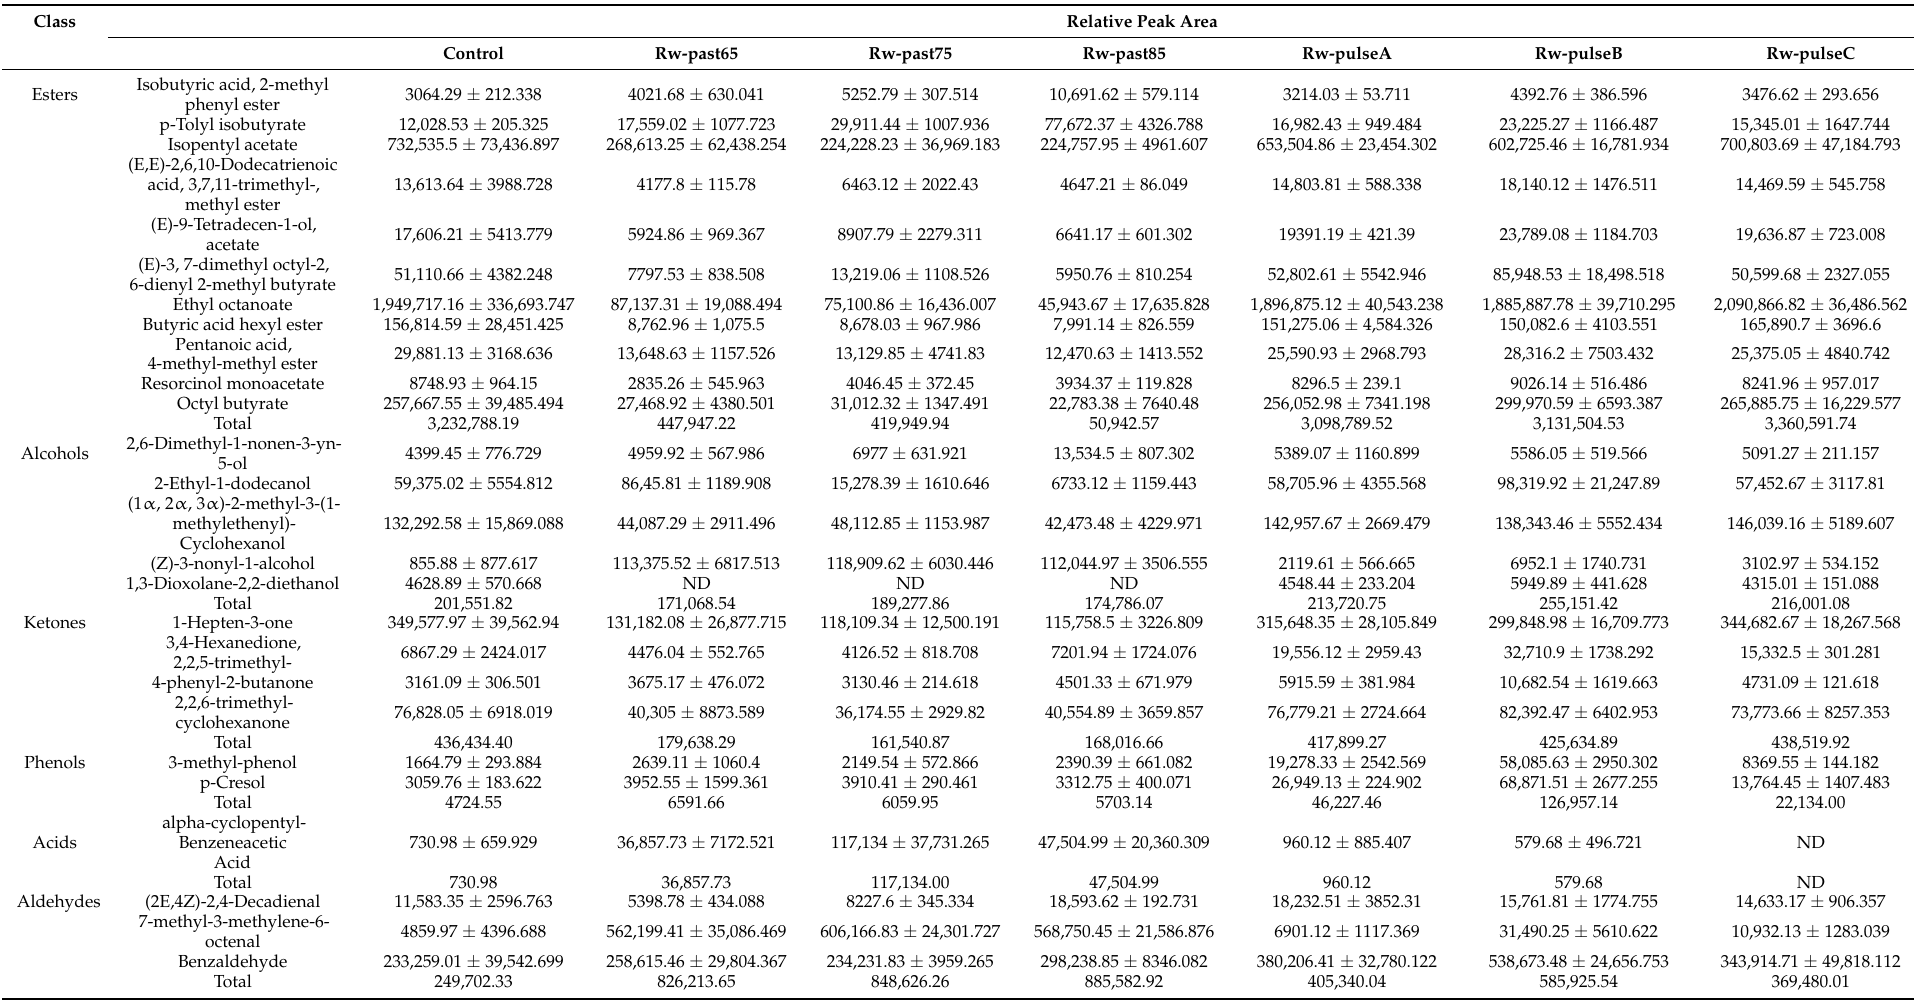
Table 4. Differences of main flavor metabolites in SRW before and after